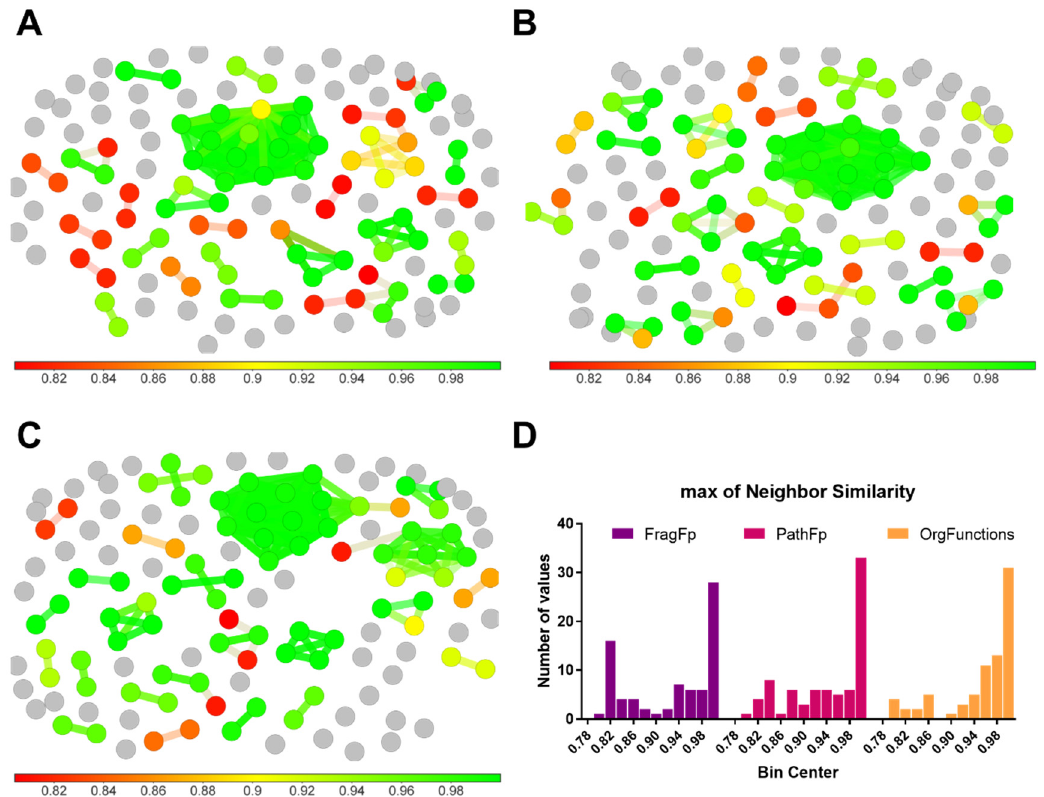
Figure 5. Similarity analysis of the chemical space using different descriptors. The level of similarity is indicated by a color scale bar (located at the bottom of each dot plot), from red (similarity = 0.8) to green (similarity = 1.0). Similarity analysis of the compound library was performed using ( A ) FragFp descriptor, ( B ) PathFp descriptor and ( C ) OrgFunctions descriptor. ( D ) Distribution frequency of each similarity value calculated by each descriptor.